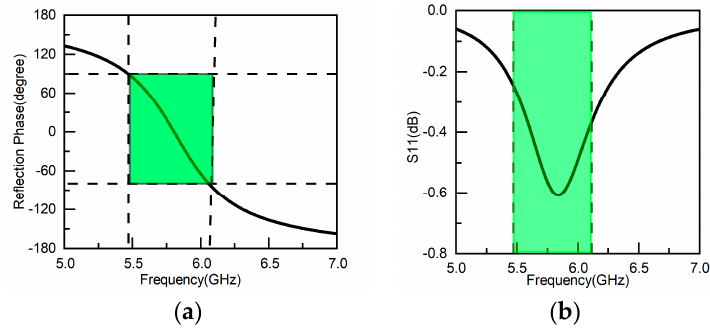
Figure 3. The reflection coefficients: ( a ) phase and ( b ) amplitude.